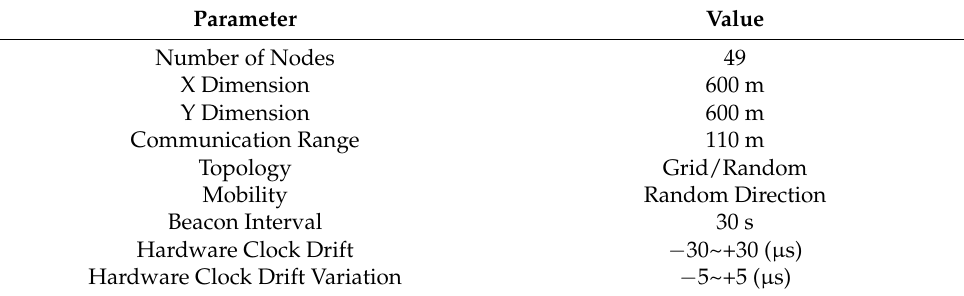
Figure 6. Mesh and random topologies for node placement. Table 1. System